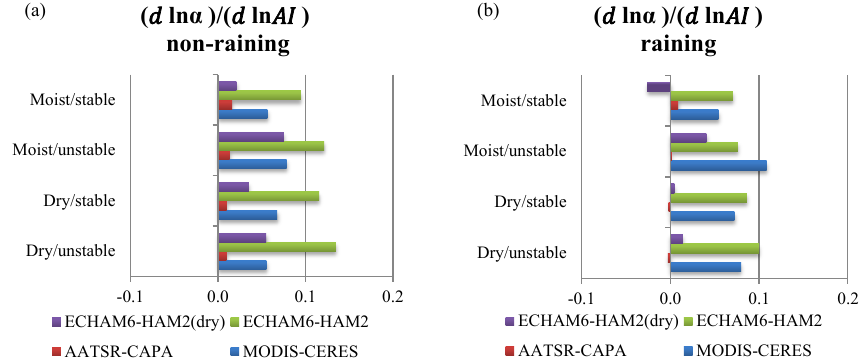
Figure 5. Same as Fig. 3 but for the shortwave cloud albedo susceptibility to changes in AI for ECHAM6-HAM2 (E6_Ref), E6_Ref without aerosol water uptake (dry), AATSR–CAPA and MODIS–CERES. The MODIS–CERES data are from Christensen et al. (2016).